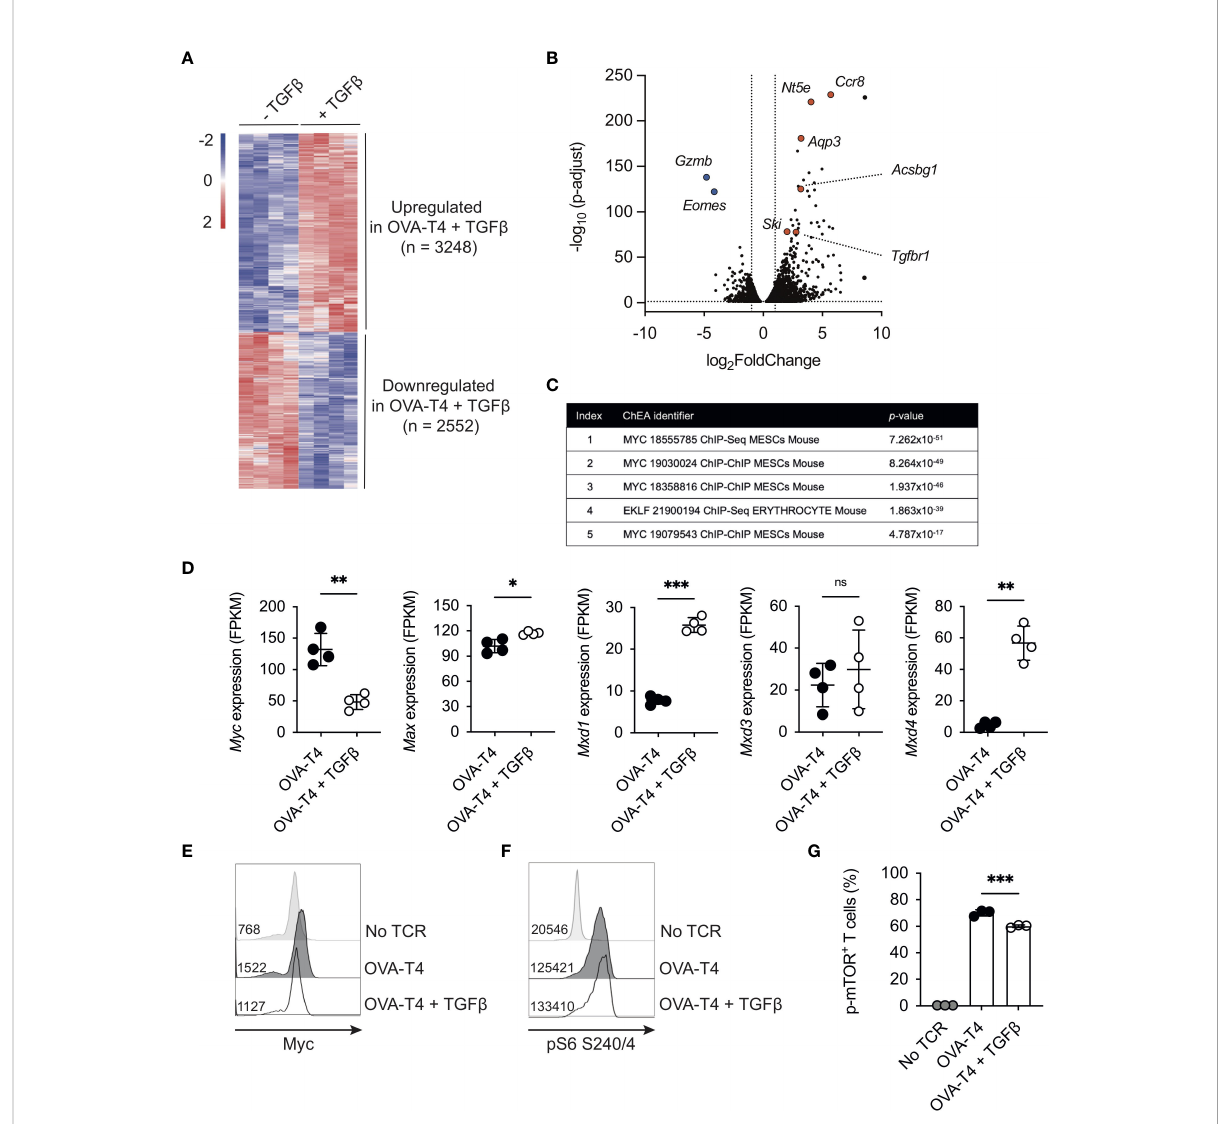
FIGURE 2 TGF b impedes the Myc-dependent transcriptome OT-I TCR transgenic T cells were stimulated with SIITFEKL (OVA-T4) peptide in the presence or absence of TGF b for 24 (A – D, F, G) or 48 (E) hours. RNA-Sequencing (RNA-Seq) analysis was performed (A) The heatmap shows log 2 fold changes of differentially expressed genes (p adjust <0.05). (B) Volcano plot of RNA-Seq data identi fi es genes substantially downregulated ( Gzmb , Eomes ) or upregulated ( Nt5e , Ccr8 , Aqp3 , Ski , Tgfbr1 , Acsbg1 ) in TGF b -treated OT-I T cells. (C) ChIP-X enrichment analysis (ChEA) within the Enrichr platform identi fi ed Myc-regulated genes as highly enriched within the TGF b -downregulated gene set. (D) Levels of gene expression of Myc and Myc-associated genes. Data shown represent fragments per kilobase million (FPKM) values taken from RNA-Seq analysis. Histograms show levels of Myc expression (E) and phosphorylated ribosomal protein S6 (pS6) (F) whilst barcharts show proportions of total OT-I cells expressing phospho-Ser2448 mTOR (G) as determined by intracellular staining and fl ow cytometry. In histograms, fi gures represent MFI values for each condition. Individual data points from RNA-Seq data (A – D) represent biological replicates (n=4), whilst FACS plots represent data from 1 of 3 repeated experiments (E, F) or technical replicates (n=3) from 1 of 2 repeated experiments (G) . For RNA-Seq data, NS – not signi fi cant, * p<0.05, ** p<0.01, *** p<0.001 as determined using DESeq2 package with p -values adjusted using Benjamini-Hochberg procedure. For (G) , *** p<0.001 as determined by one way ANOVA, with Tukey's multiple comparisons